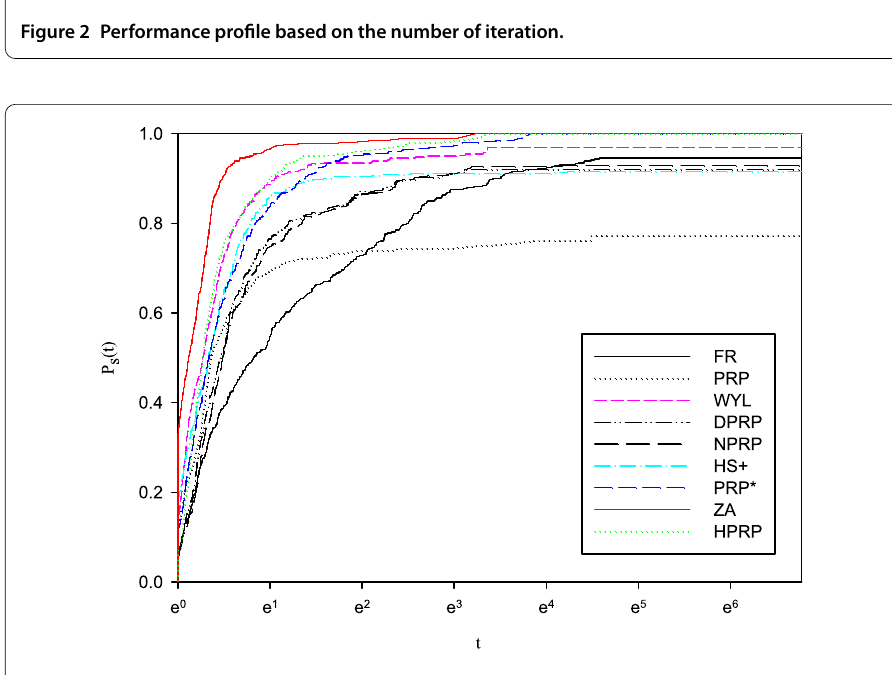
Figure 3 Performance profile based on the CPU